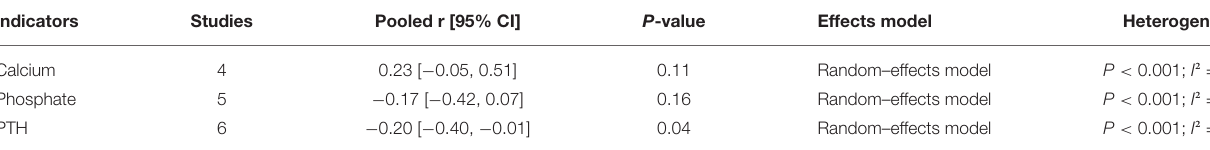
TABLE 4 | Results of the association of sKlotho level with calcium, phosphate and PTH.